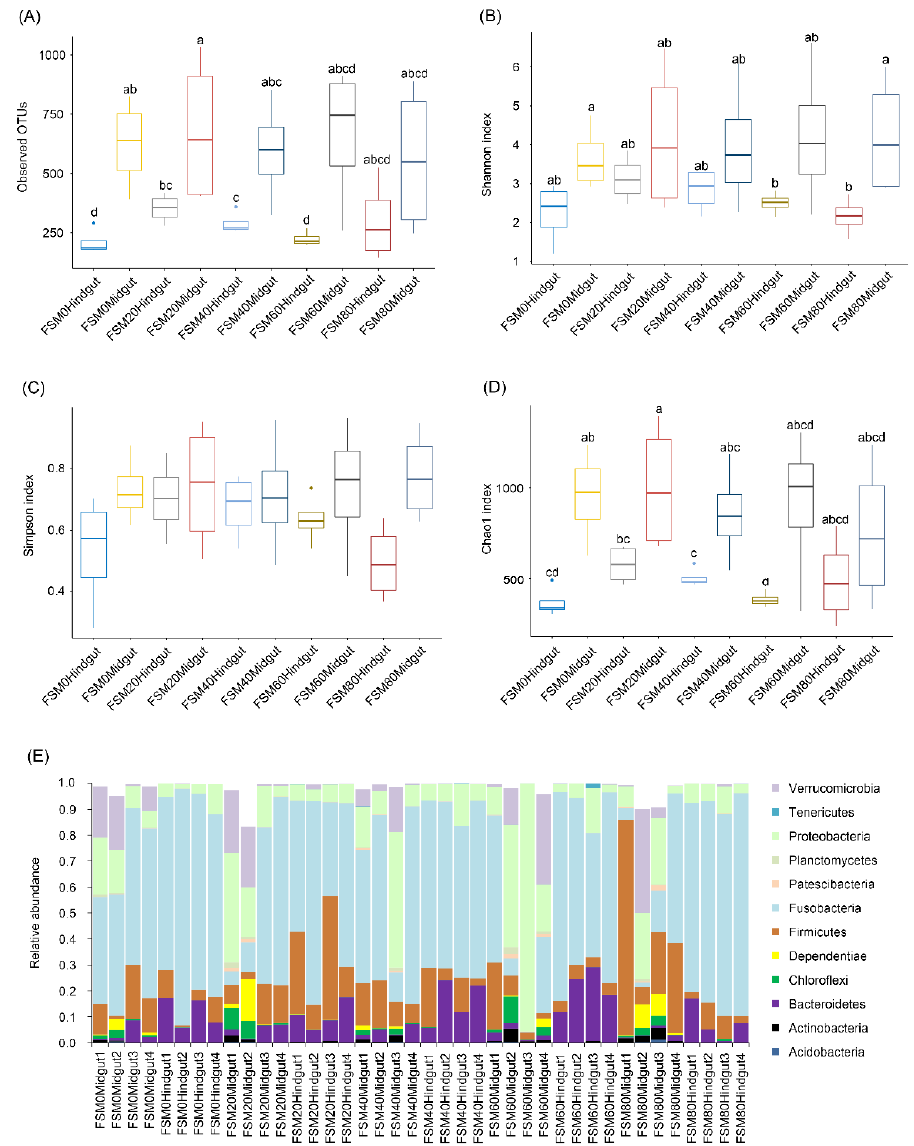
Figure 2. α -diversity indices and dominant phylum compositions of gut microbiota of crucian carp ( Carassius auratus ). ( A ) number of observed OTUs; ( B ) Shannon index; ( C ) Simpson index; ( D ) Chao1 index; ( E ) relative abundance of dominant phyla in the gut microbiota of C. auratus .